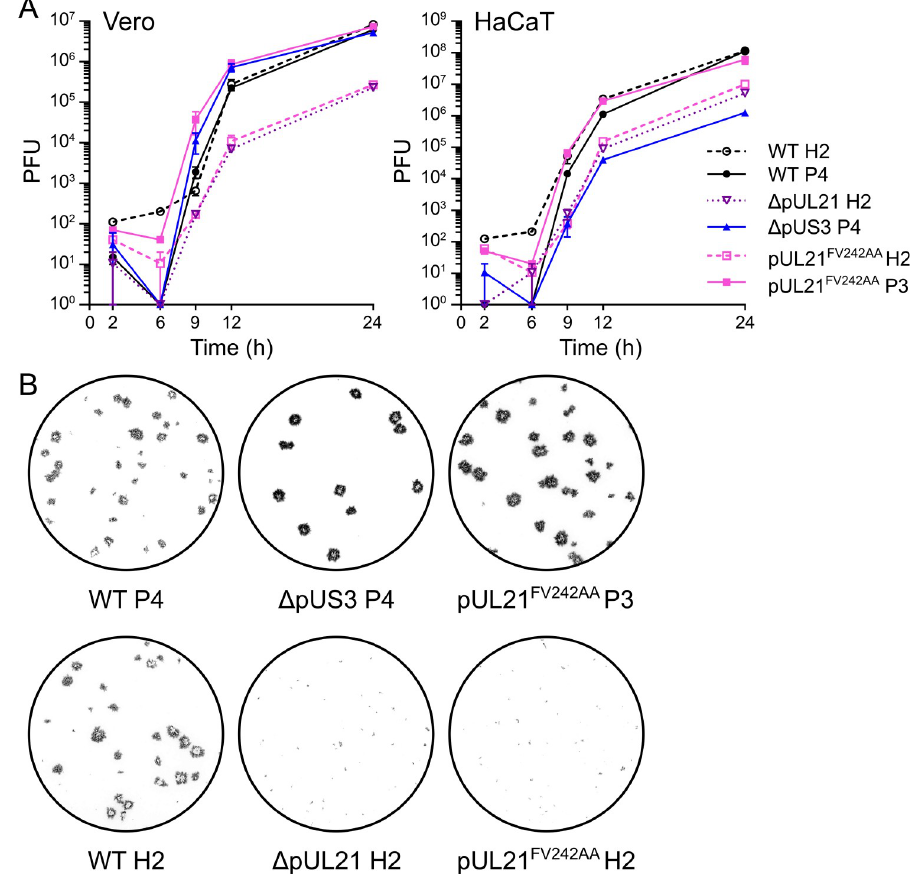
Fig 5. Abolition of pUL21 PP1 binding severely restricts HSV-1 replication and spread. ( A ). Single-step (high MOI) growth curve of WT and mutant HSV-1. Monolayers of Vero and HaCaT cells were infected (MOI = 5) with the indicated viruses, prepared following amplification of the original rescued stock for three or four generations in Vero cells (P3 and P4, respectively) or for two generations in HaCaT cells stably expressing pUL21 (H2). Samples were harvested at the indicated times and titers were determined by plaque assay using Vero cells. Data are presented as mean values of duplicates of one representative experiment. Error bars represent standard error of the mean (not shown where errors are smaller than the symbols). ( B ) Representative plaque assays used to titre the single-step growth curve shown in ( A ). Monolayers of Vero cells were infected with viruses harvested from titration, overlaid with medium containing 0.6% carboxymethyl cellulose, and then fixed and immunostained with chromogenic detection at 48 h post-infection.